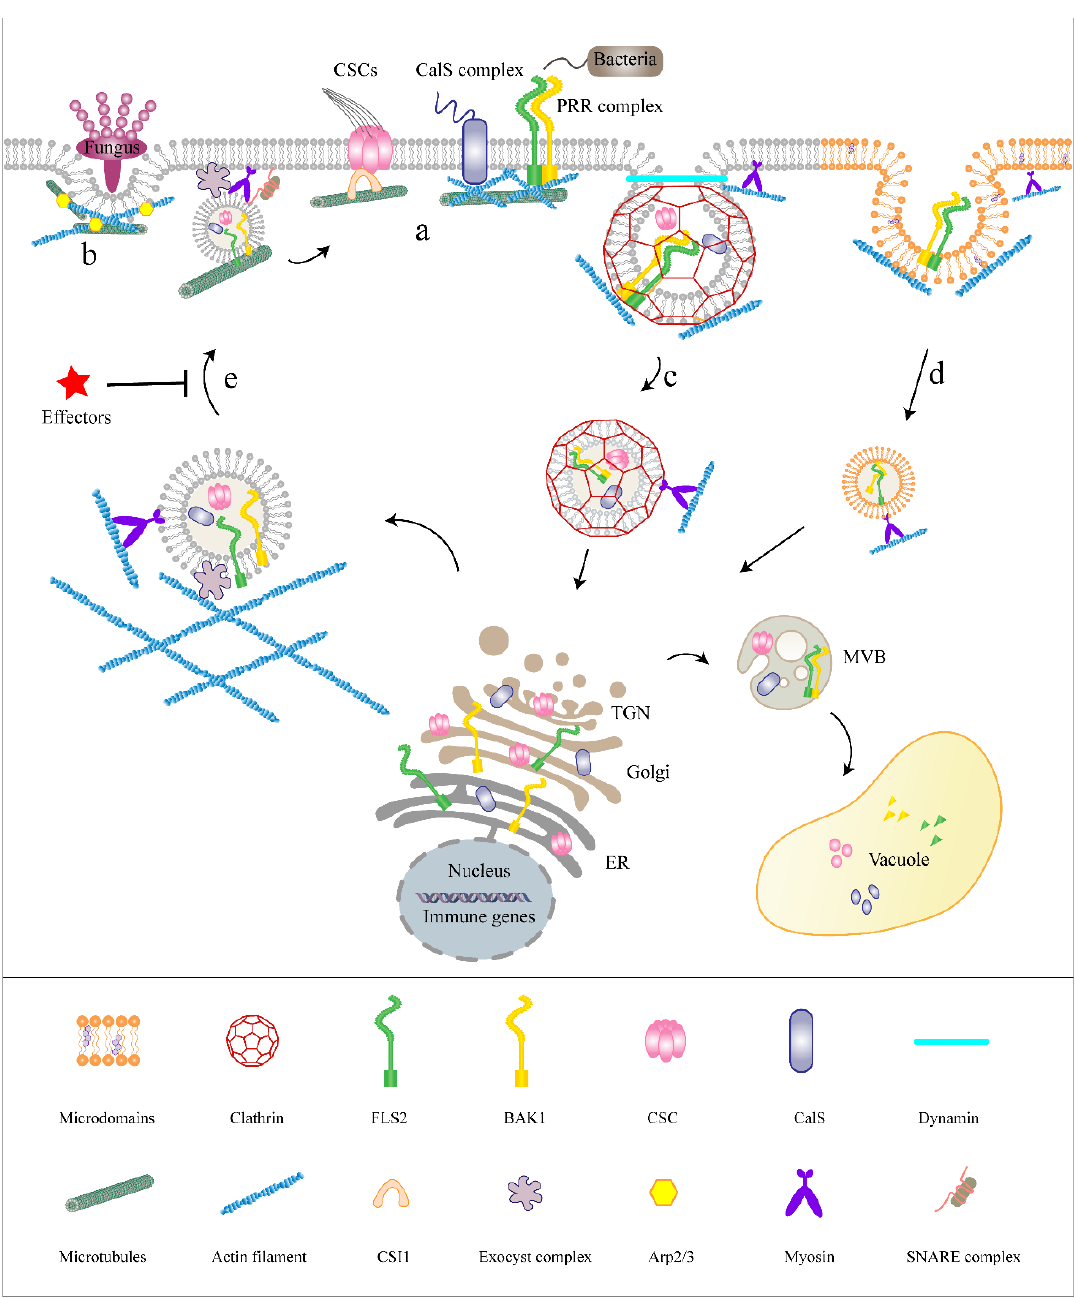
Figure 2. Plant cytoskeleton network regulates endocytic membrane trafficking during the immune response. (a) The plant cytoskeleton offers microenvironments for PRR complexes, CalS complexes and CSCs. (b) The rapid recombination of MF and MT are triggered by the invasion of avirulent fungal strains. (c) The endocytosis of PRR complexes and CW biosynthesis components are predominantly mediated by CME, which require actin cytoskeletons and myosin motors. (d) The turnover of PRR complexes through CIE, which depend on the actin cytoskeleton and myosin motors. (e) The secretion of immune proteins are enhanced under PAMP perception, transporting from TGN to the plasma membrane along the actin cytoskeleton. Pathogen effectors inhibit the secretory trafficking pathways to block defense